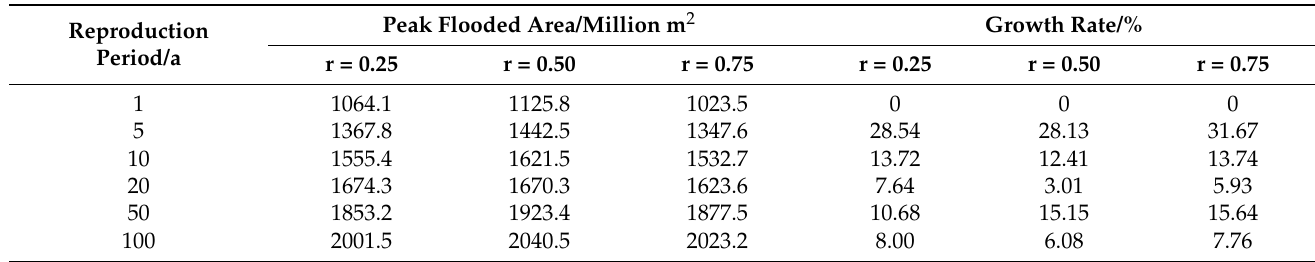
period is greater than 20 years, the inundation area produced by rainfall with r = 0.25 is lower than that produced by rainfall with r = 0.75. Except for the return period of 20 years, the ponded area for r = 0.5 is greater than r = 0.25 and r = 0.75. Table 4. Peak inundated area and growth rate under different rainfall